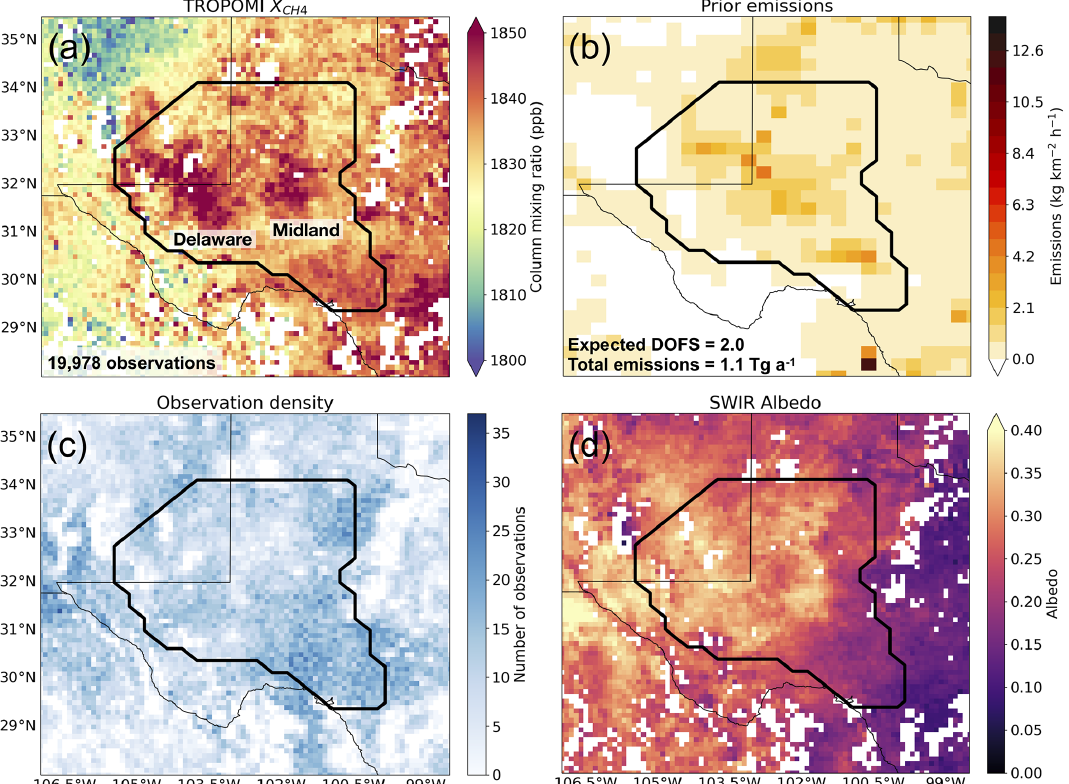
Figure 5. Output of the IMI preview (Sect. 2.7) applied to the Permian Basin example with the default EPA gridded GHGI inventory (Maasakkers et al., 2016) as prior estimate of emissions. (a) Mean TROPOMI column-average dry-air methane mixing ratio ( X CH for the user-selected region (thick black contour) and period of interest (1–31 May 2018), resampled to a 0.1 ◦ × 0.1 ◦ grid and cropped to 28–35.5 ◦ N, 98.5–107 ◦ W for visibility. The color bar is saturated to highlight methane hotspots over the Delaware and Midland sub-basins. Inset gives the total number of observations and degrees of freedom for signal (DOFS) for the region of interest. (b) Gridded GHGI (default) prior emissions. (c) Number of observations per 0.1 ◦ × 0.1 ◦ grid cell for the period of interest. (d) Mean SWIR albedo for the period of interest on the 0.1 ◦ × 0.1 ◦ grid. Here the preview shows poor agreement in the spatial distribution of emissions between the observations and prior emission estimates, suggesting that the prior estimate should be replaced by a better one (as is done in our application) or that the prior error estimate should be